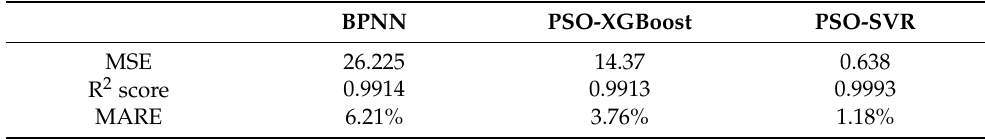
Figure 11. Comparison of BP neural network and SVR performance prediction model. ( a – c ) are the are the comparisons of head, power and efficiency. Table 5. Comparison of PSO-SVR, PSO-XGBoost, and BP neural network